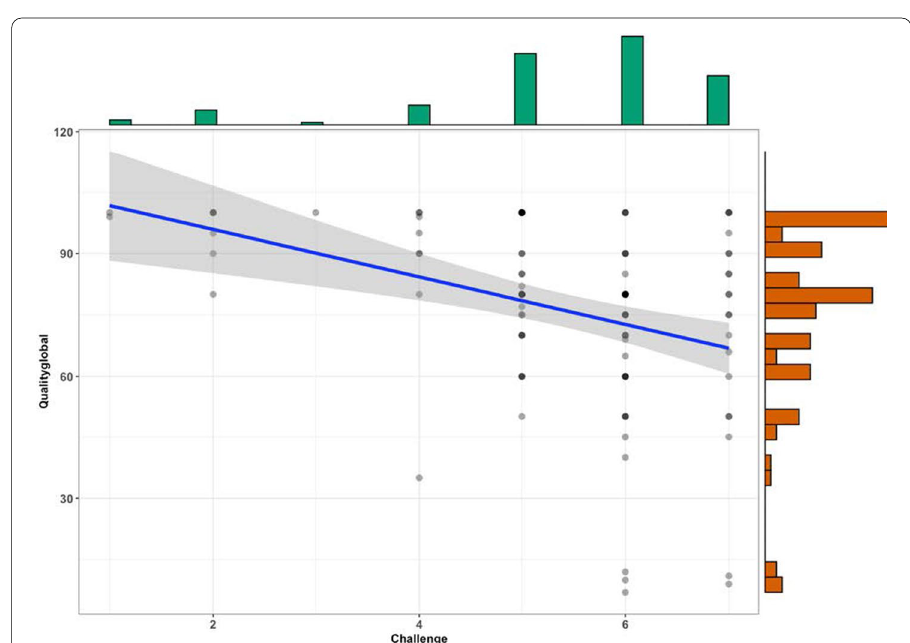
Fig. 1 Bivariate relationship of teaching quality and perceived challenge during ERT